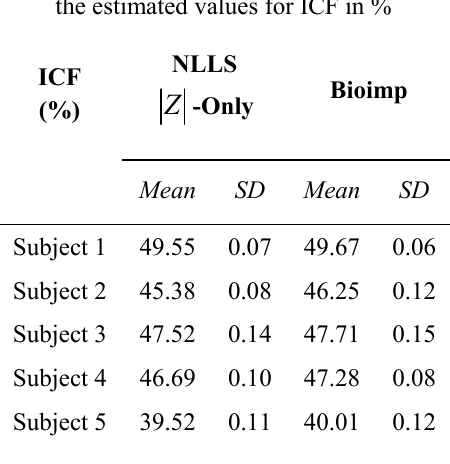
Table VI. Mean and Standard Deviation of the estimated values for ICF in %